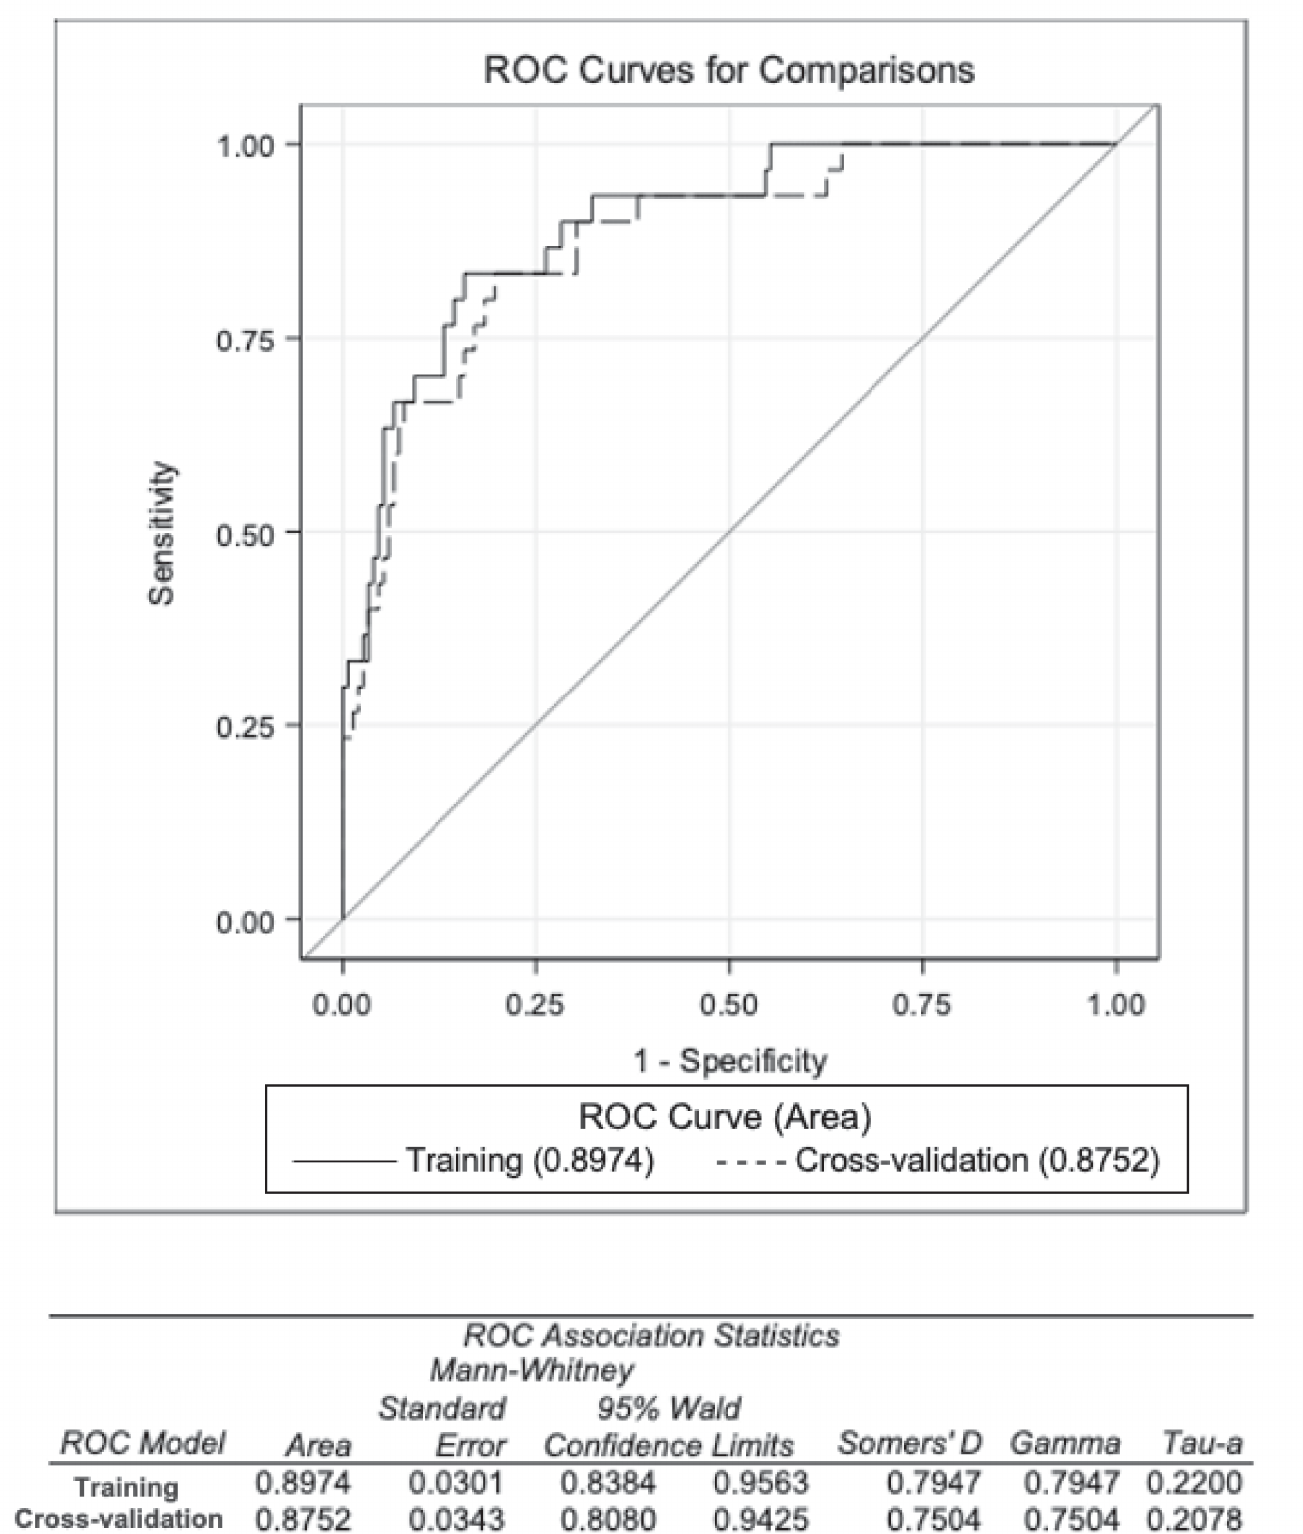
Fig 2. AUC under the ROC for composite endpoint in test set. https://doi.org/10.1371/journal.pone.0247275.g002 PLOS ONE | https://doi.org/10.1371/journal.pone.0247275 February 23,